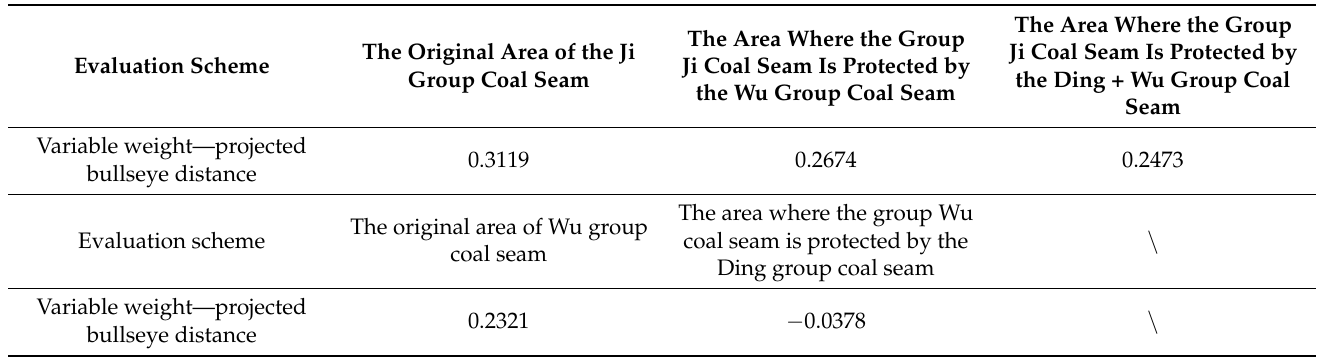
Table 7. Quantification of the coal seams’ degree of protection before and after protective layer mining.